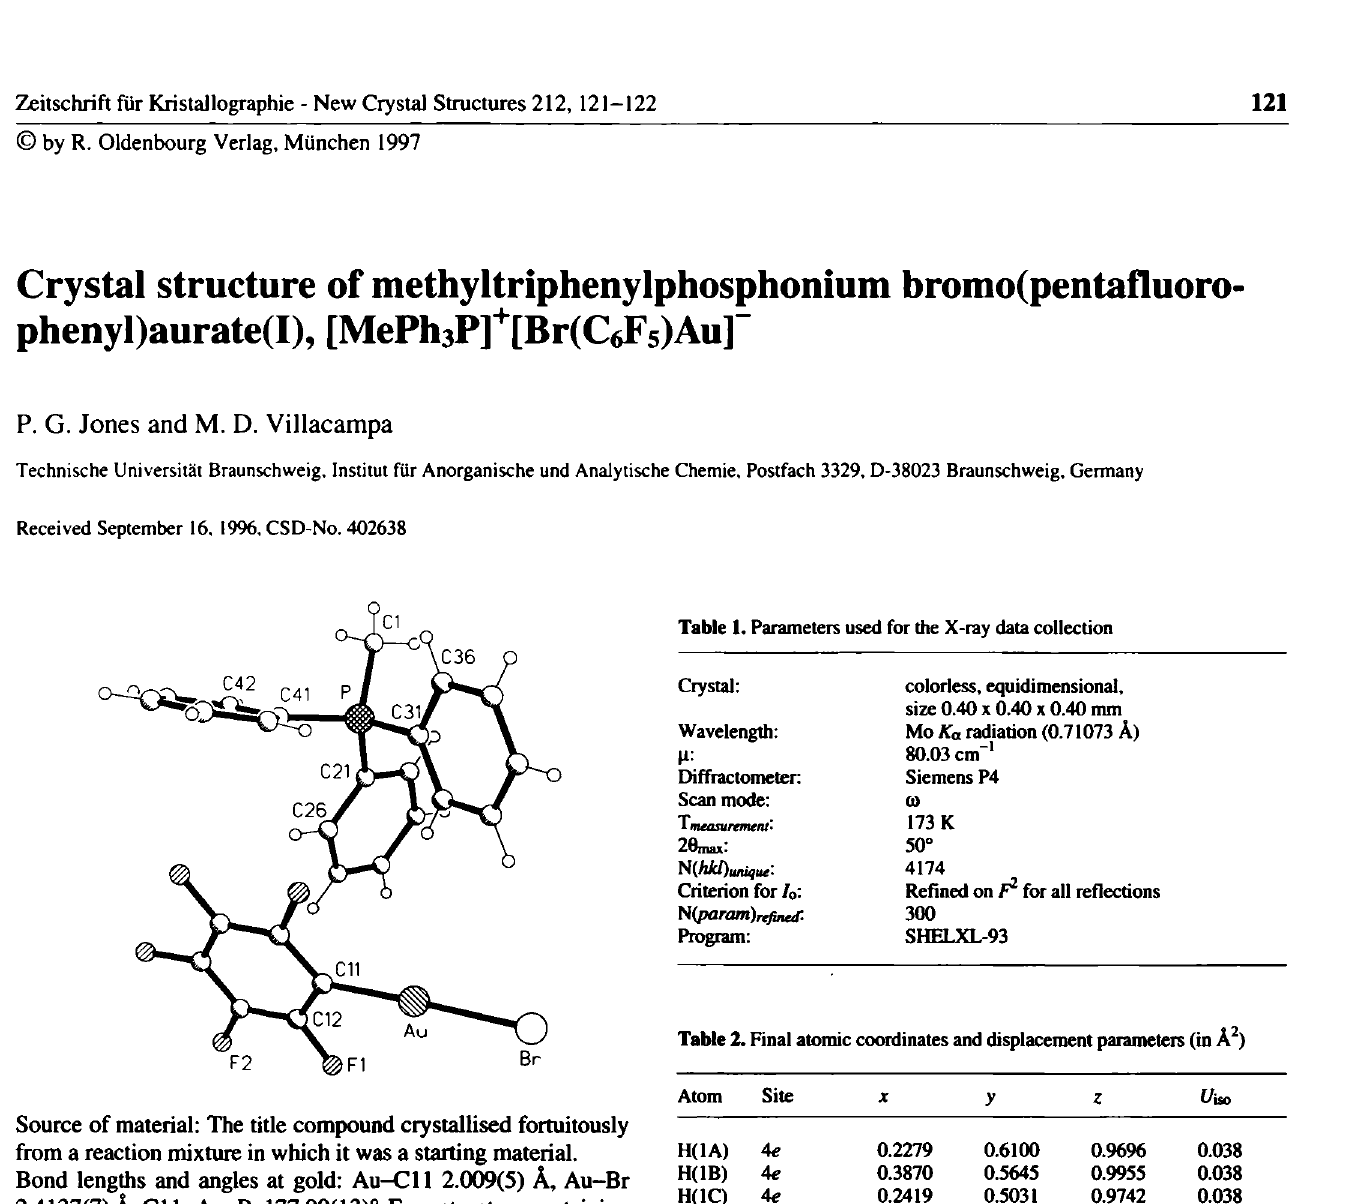
Source of material: The title compound crystallised fortuitously from a reaction mixture in which it was a starting material.